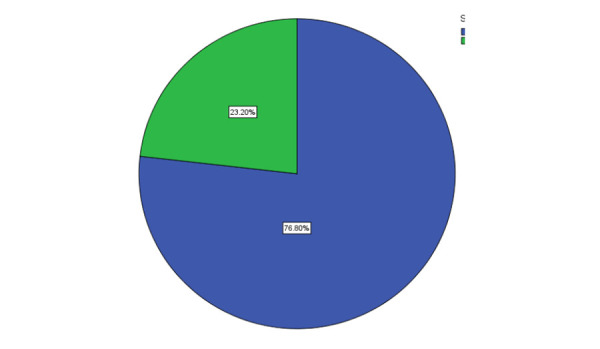
Male versus female.